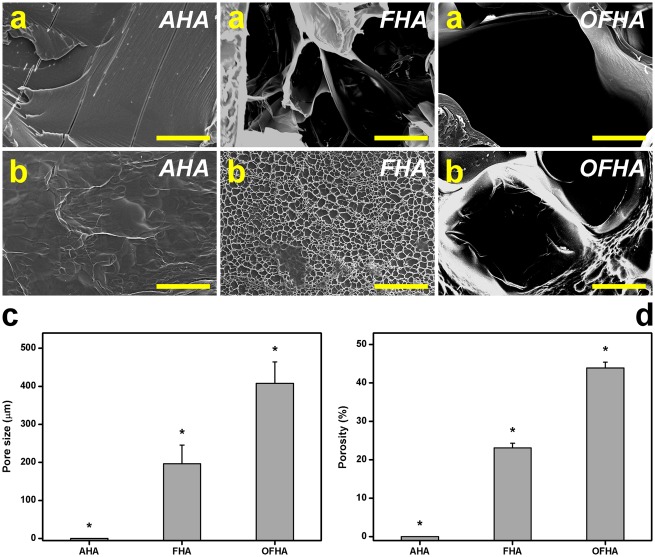
(a) Cross-section and (b) surface images obtained by scanning electron microscopy of the HA carriers. Scale bars: 100 μm. (c) Pore size and (d) porosity of various HA carriers. Values are mean ± SD (n = 4). *P < 0.05 vs all groups.